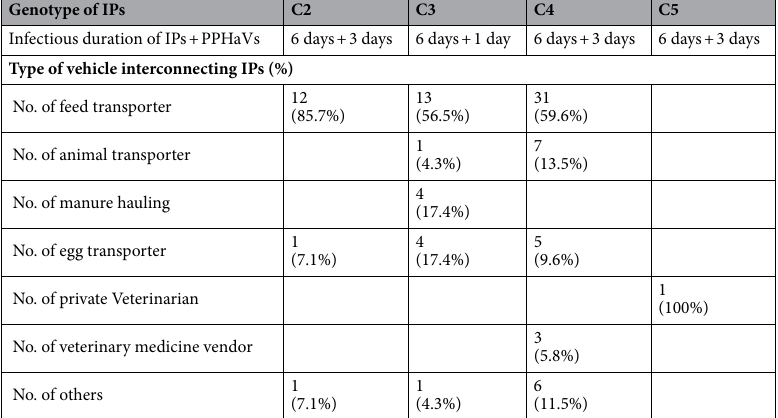
Table 5. Summary of the type of vehicle interconnecting between the same HPAI H5N6 virus genotype of infected premises based on Bayesian parameter inference results. HPAI highly pathogenic avian influenza, IP infected premises, PPHaV poultry production and health associated